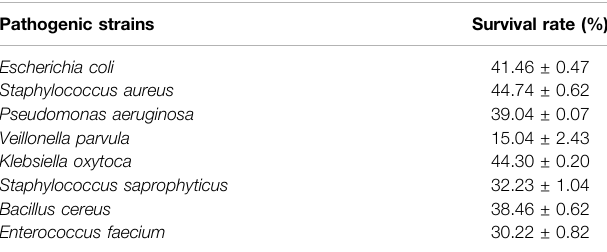
TABLE 4 | Co-aggregation assay of Bacillus paranthracis MHSD3.